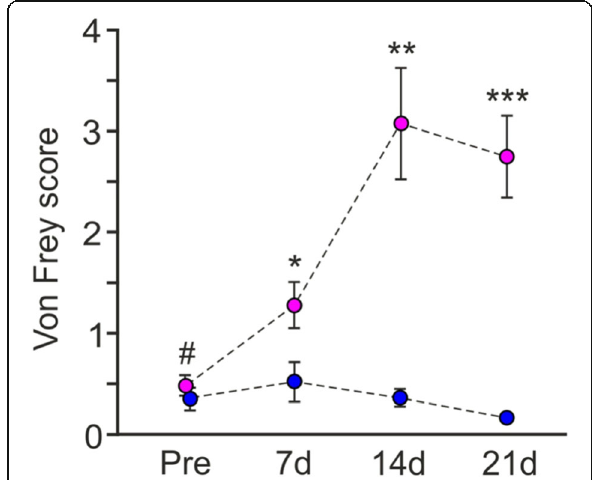
Fig. 2 Testing withdrawal responses to whisker pad mechanical stimulation with von Frey filaments shows a distinct time course over 3 weeks following unilateral (right side) CCI-IoN. The response score differed significantly between sham-operated (blue; n = 10) and CCI-IoN (magenta; n = 16) groups regarding Group (F 1,107 = 28.906, p < 0.001) and Time (F 3,6 = 4.217, p = 0.007), and also showed significant Group x Time interaction (F 3,107 = 5.228, p = 0.002). Data represent means ± SEM, two-way ANOVA with repeated